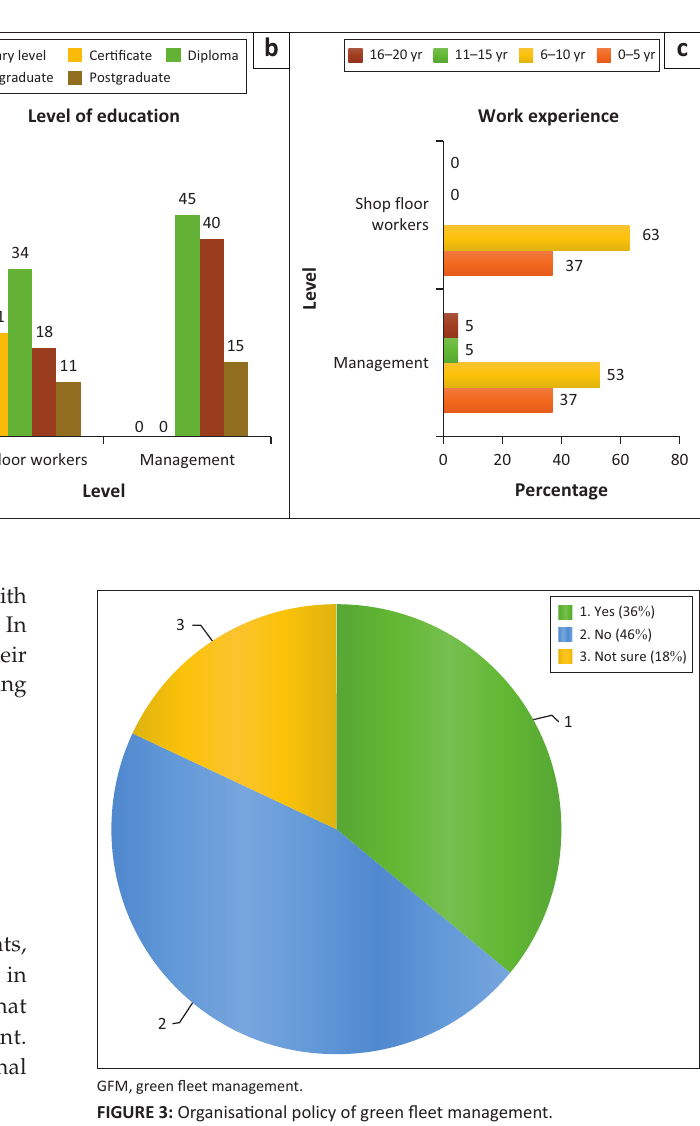
FIGURE 3: Organisational policy of green fleet management.